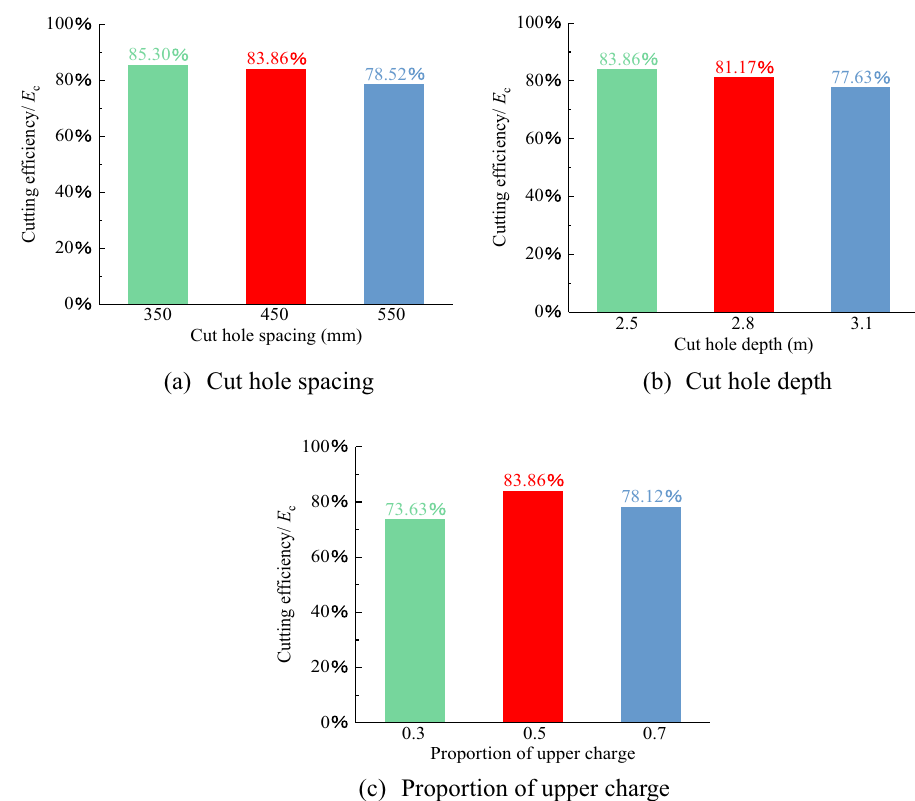
Fig. 19 Cutting efficiency corresponding to different cutting parameters. a Cut hole spacing; b Cut hole depth; c Proportion of upper